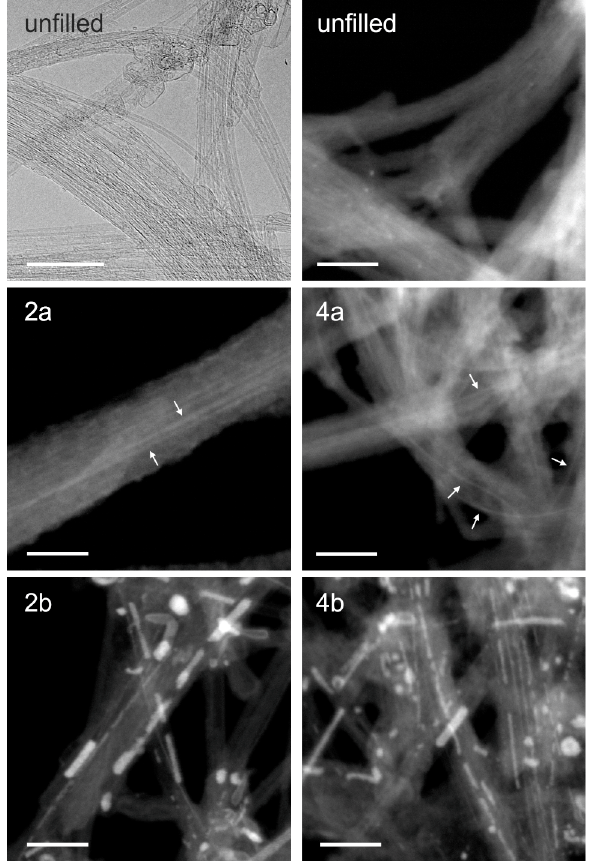
Figure 6. HRTEM and HAADF-STEM images of unfilled SWCNTs (first row); HAADF-STEM images of 2a , 4a , 2b and 4b . Scale bar: 20 nm.